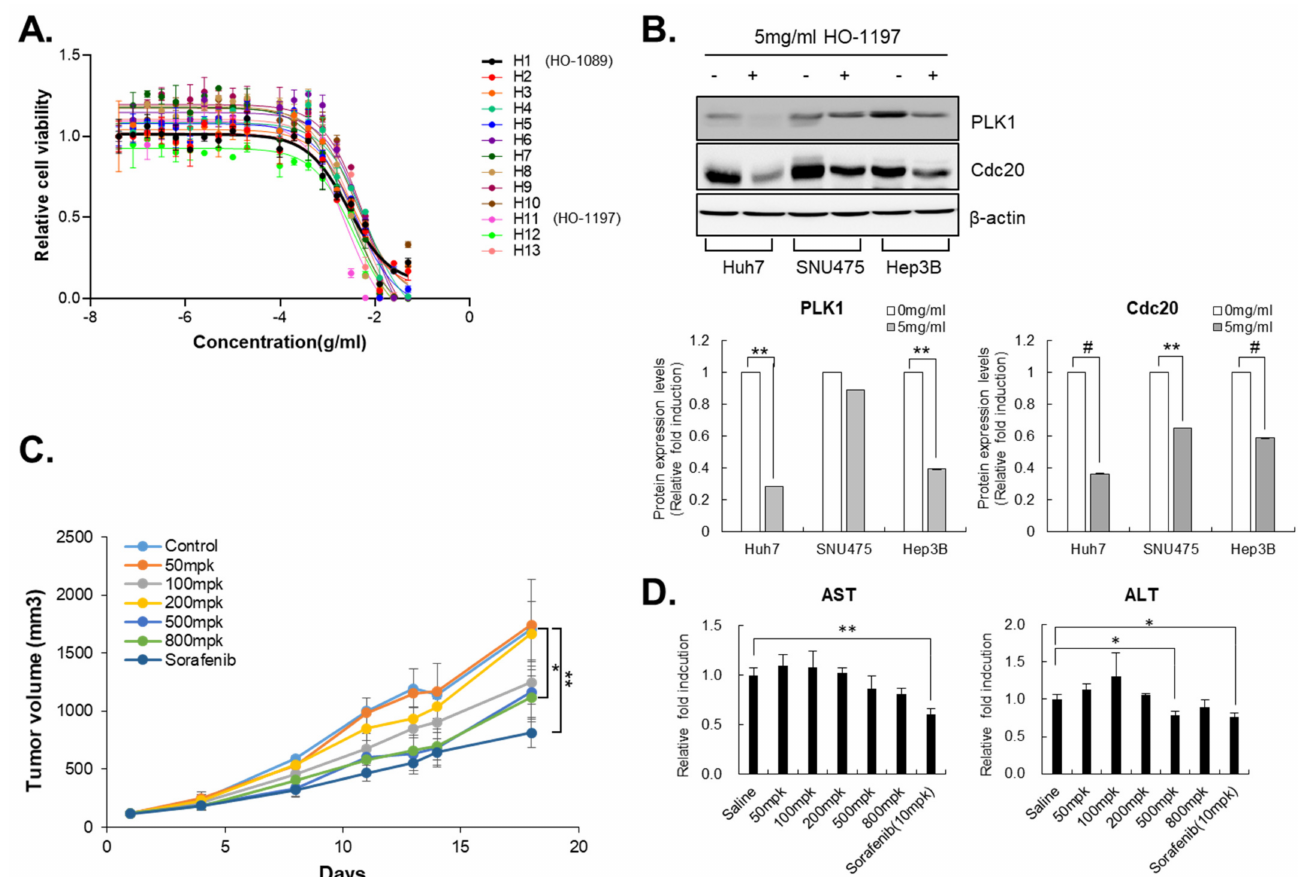
Figure 6. Key herbal combination, HO-1197, showed anticancer efficacy in HCC: ( A ) HO-1089 (H1) and 12 combinations of key ingredients including HO-1197 (H11) were used to treat HCC cells, from 50 mg/mL using 2-fold dilutions, for 48 h. Cell viability was measured using the counts of cell nuclei. ( B ) Expression levels of PLK1 and Cdc20 were examined in Huh7, Hep3B, and SNU475 cells after treatment with 5 mg/mL HO-1197 for 48 h (upper panel). The Western blot images were quantitatively analyzed (lower panel ( C , D ). In vivo efficacy of HO-1197 was examined using observation of changes in tumor volume ( C ) and liver toxicity ( D ) for 3 weeks. Data are expressed as means ± SD ( n = 3). * p < 0.05, ** p < 0.005, # p < 0.0005 compared to the control